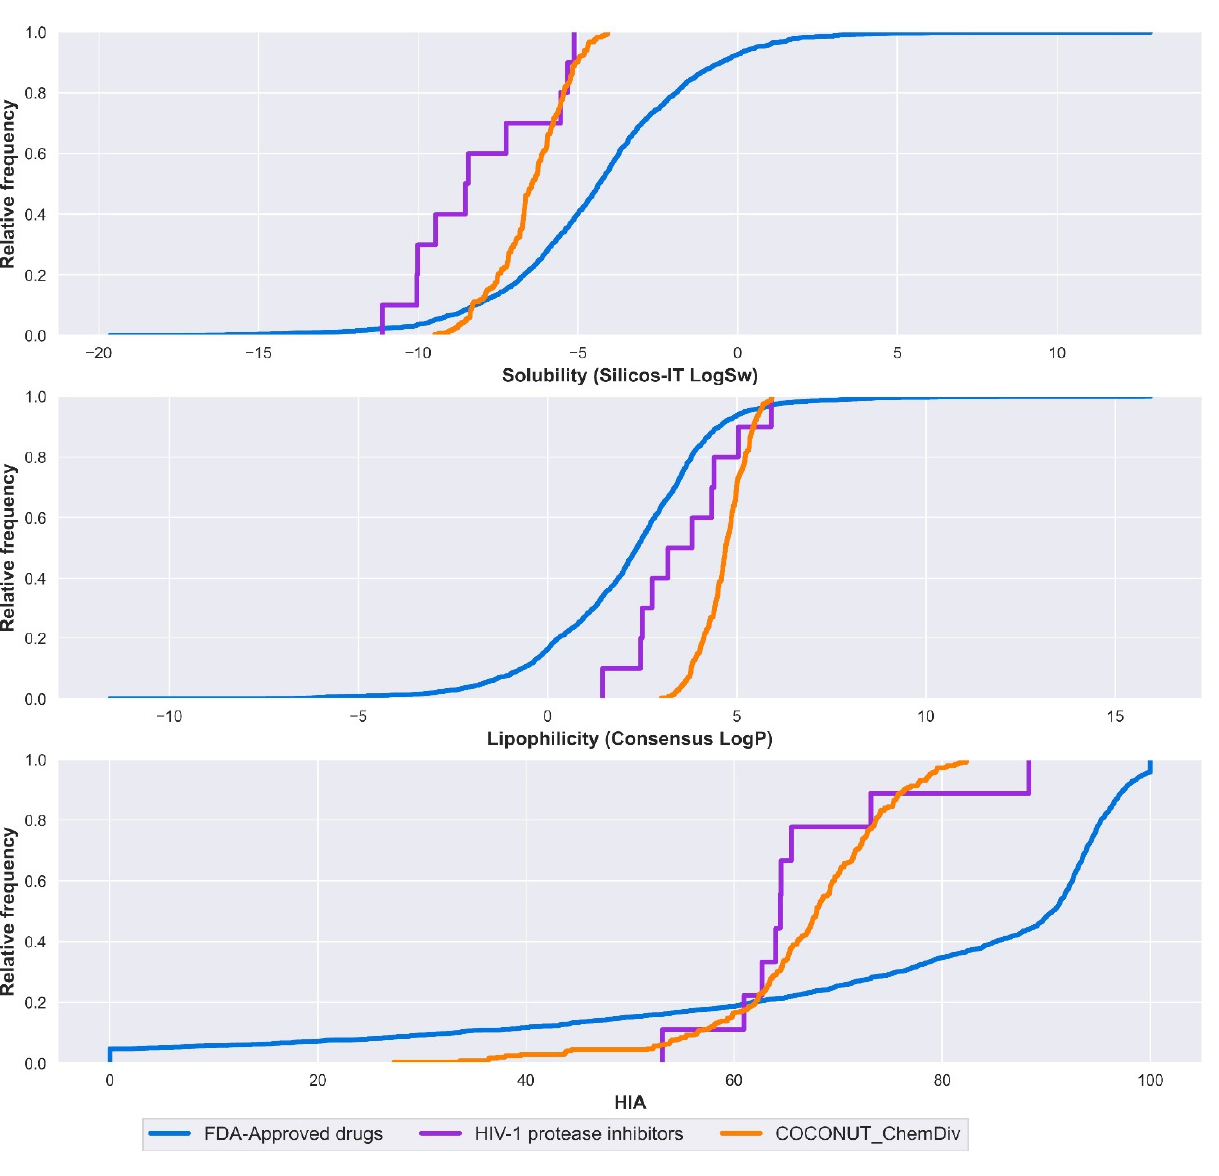
Figure 10. Distribution curve of solubility, lipophilicity, and HIA. Colors represent compounds: new chemical compounds generated from COCONUT fragments and ChemDiv fragments with physicochemical properties like FDA-approved HIV-1 protease inhibitors and easily synthetically accessible (orange), FDA-approved drugs (blue), FDA-approved HIV-1 protease inhibitors (purple). Solubility is expressed in the percentage of Silicos-IT LogSw, and lipophilicity is expressed in the percentage of consensus LogP.